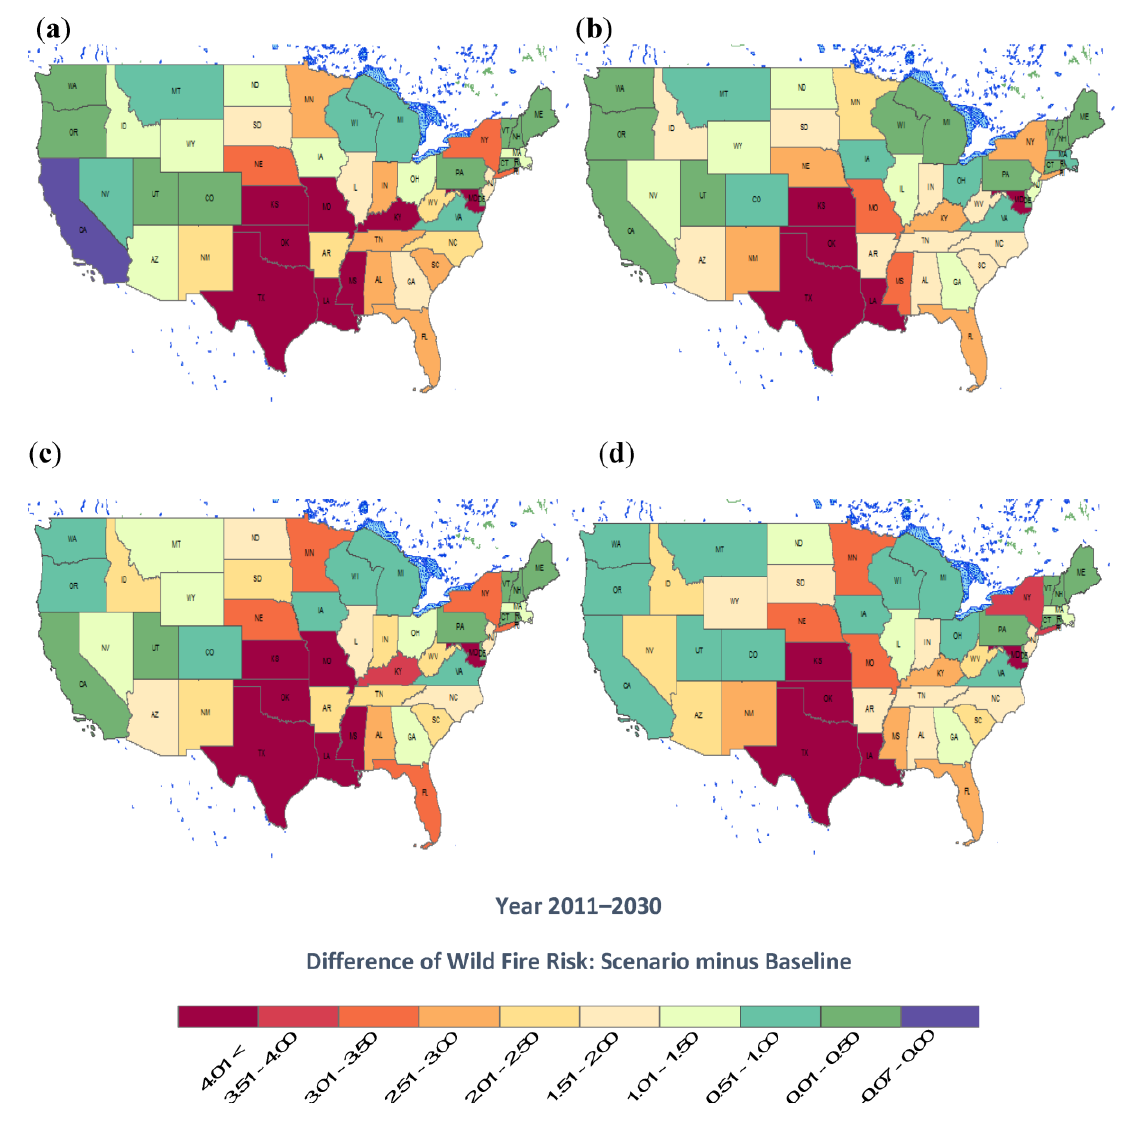
Figure 2. ( a ) Change in wildfire risk relative to the baseline (historical average) with the future climate projected by the HadCM3 model under the RCP 4.5 scenario; ( b ) Change in wildfire risk relative to the baseline with the future climate projected by the NOAA-GFDL model under the RCP 4.5 scenario; ( c ) Change in wildfire risk relative to the baseline with the future climate projected by the HadCM3 model under the RCP 8.5 scenario; ( d ) Change in wildfire risk relative to the baseline with the future climate projected by the NOAA-GFDL model under the RCP 8.5 scenario. The changes in wildfire risk are calculated by subtracting the historical average wildfire risk from the projected future wildfire risk based on the climatic conditions projected by the GCMs. This figure indicates the short-run (2011–2030) impact of climate change on wildfire